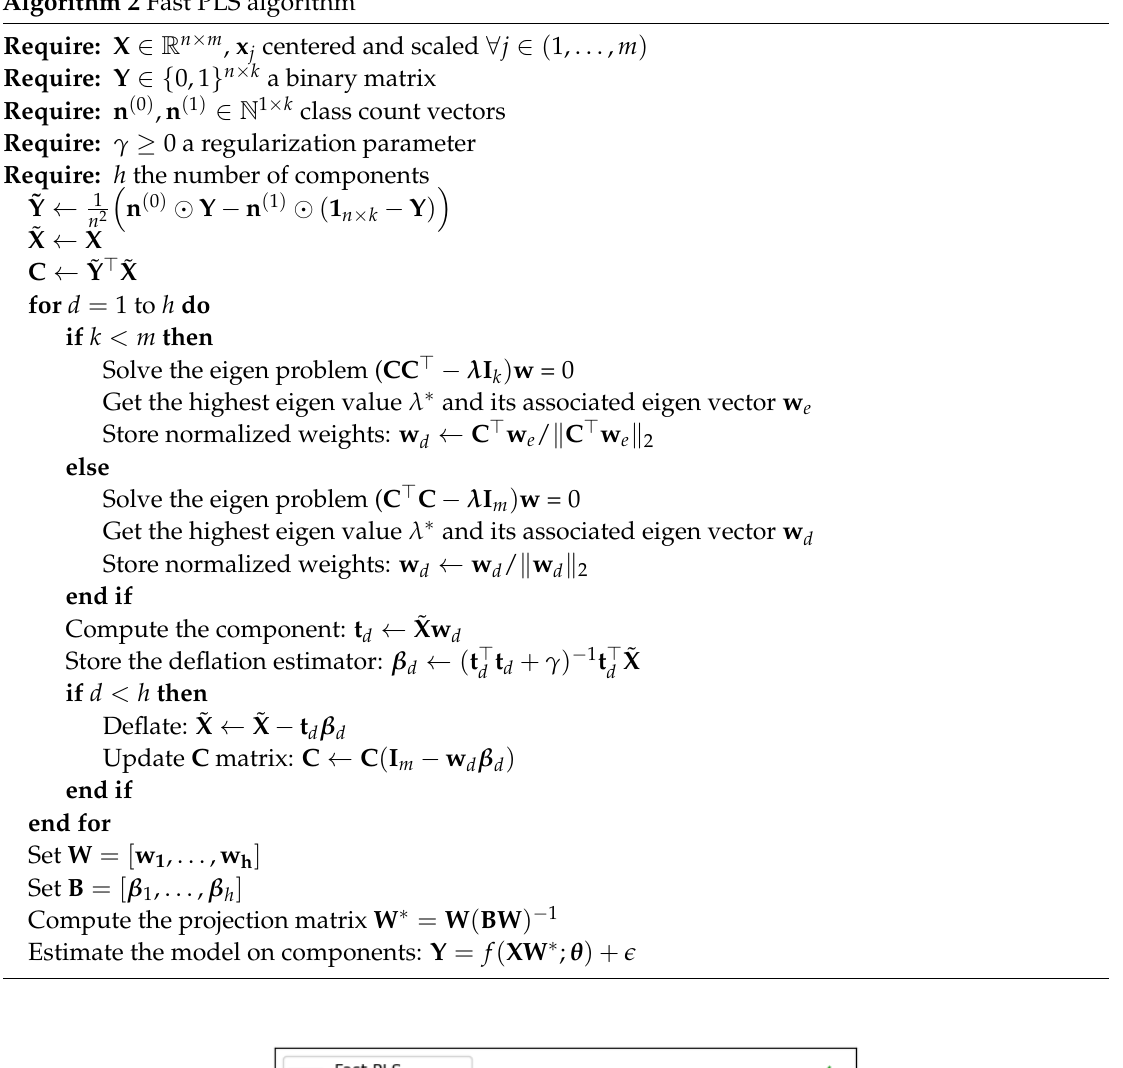
Algorithm 2 Fast PLS algorithm